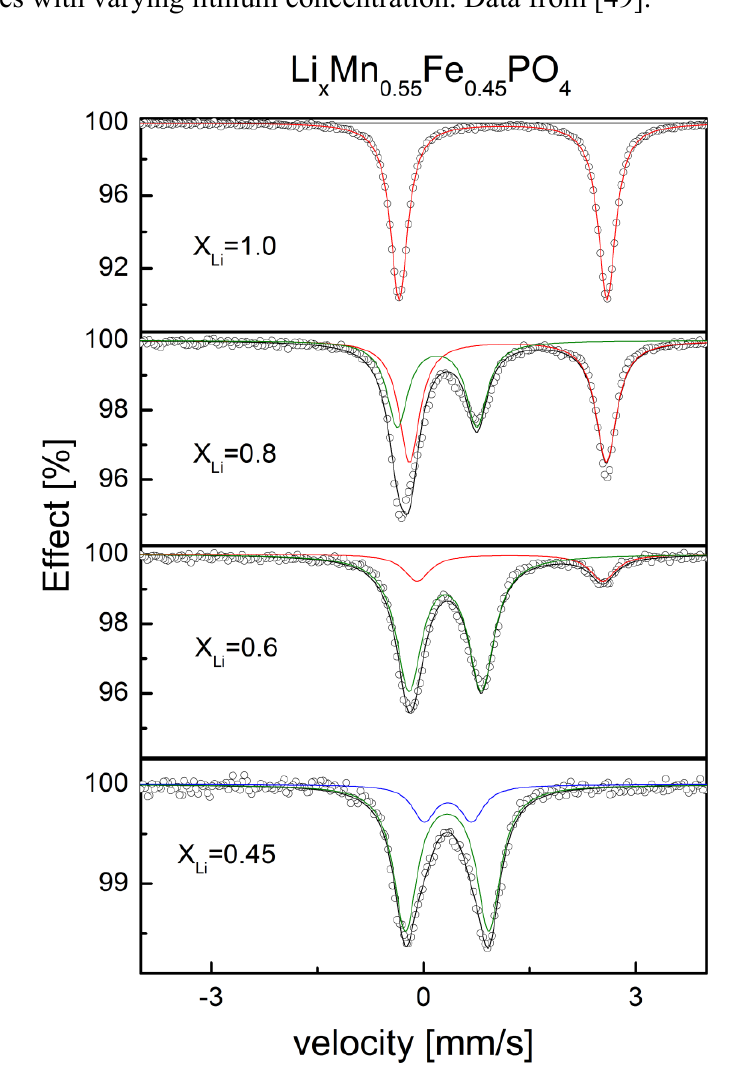
Fe Mn PO x 0.45 0.55 4